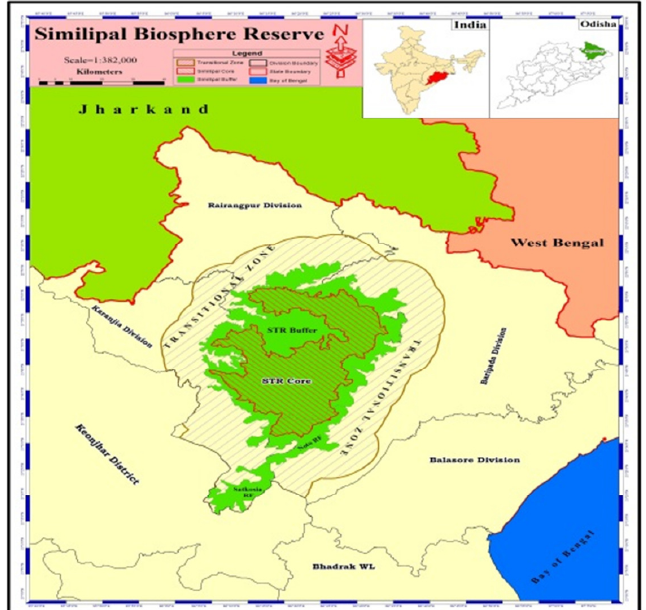
Fig. 1. Map of the study